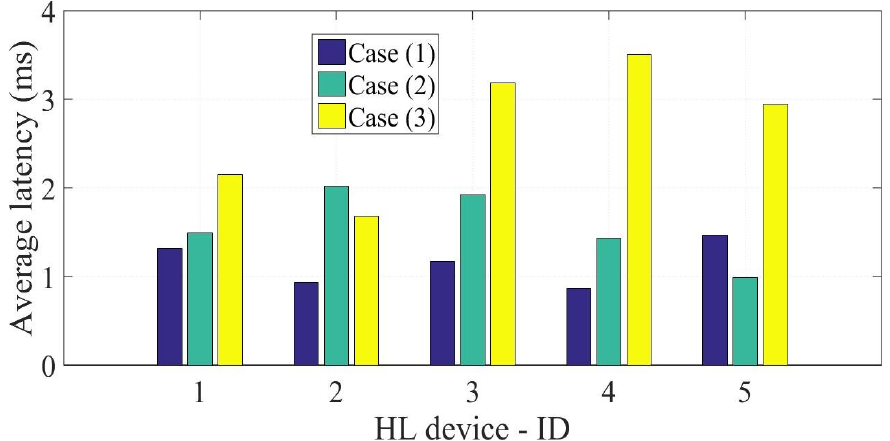
Figure 11. Average latency of handling HL devices’ tasks for the three considered cases of the first scenario.